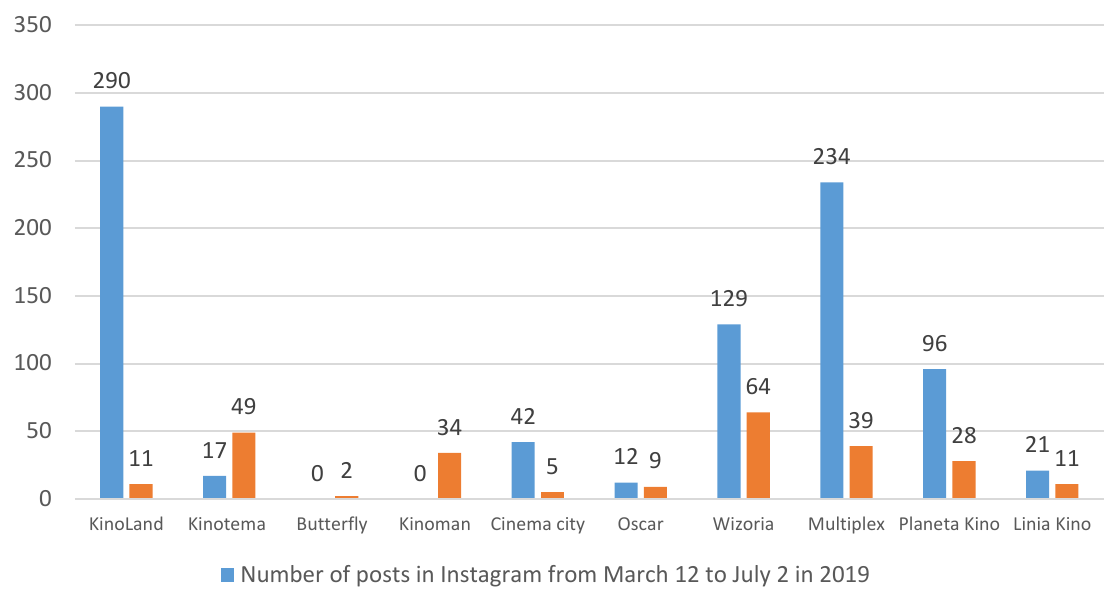
Figure 3. Number of posts on the official pages of cinema networks on Instagram for the same